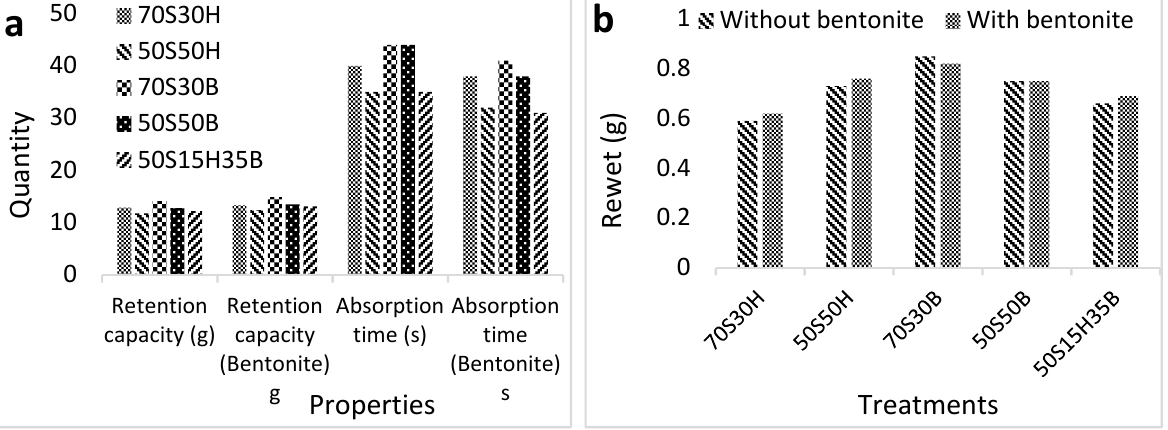
Figure 7. Retention capacity and absorption time ( a ), as well as rewet ( b ) of baby diapers produced with different fluff pulp formulations.